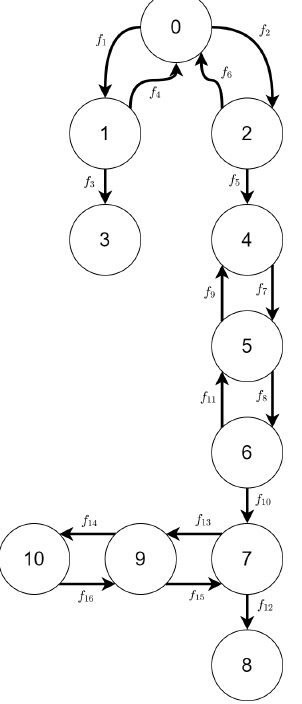
Figure 16. The state space of the first variant of scenario 2. Mission progress functions definitions are listed